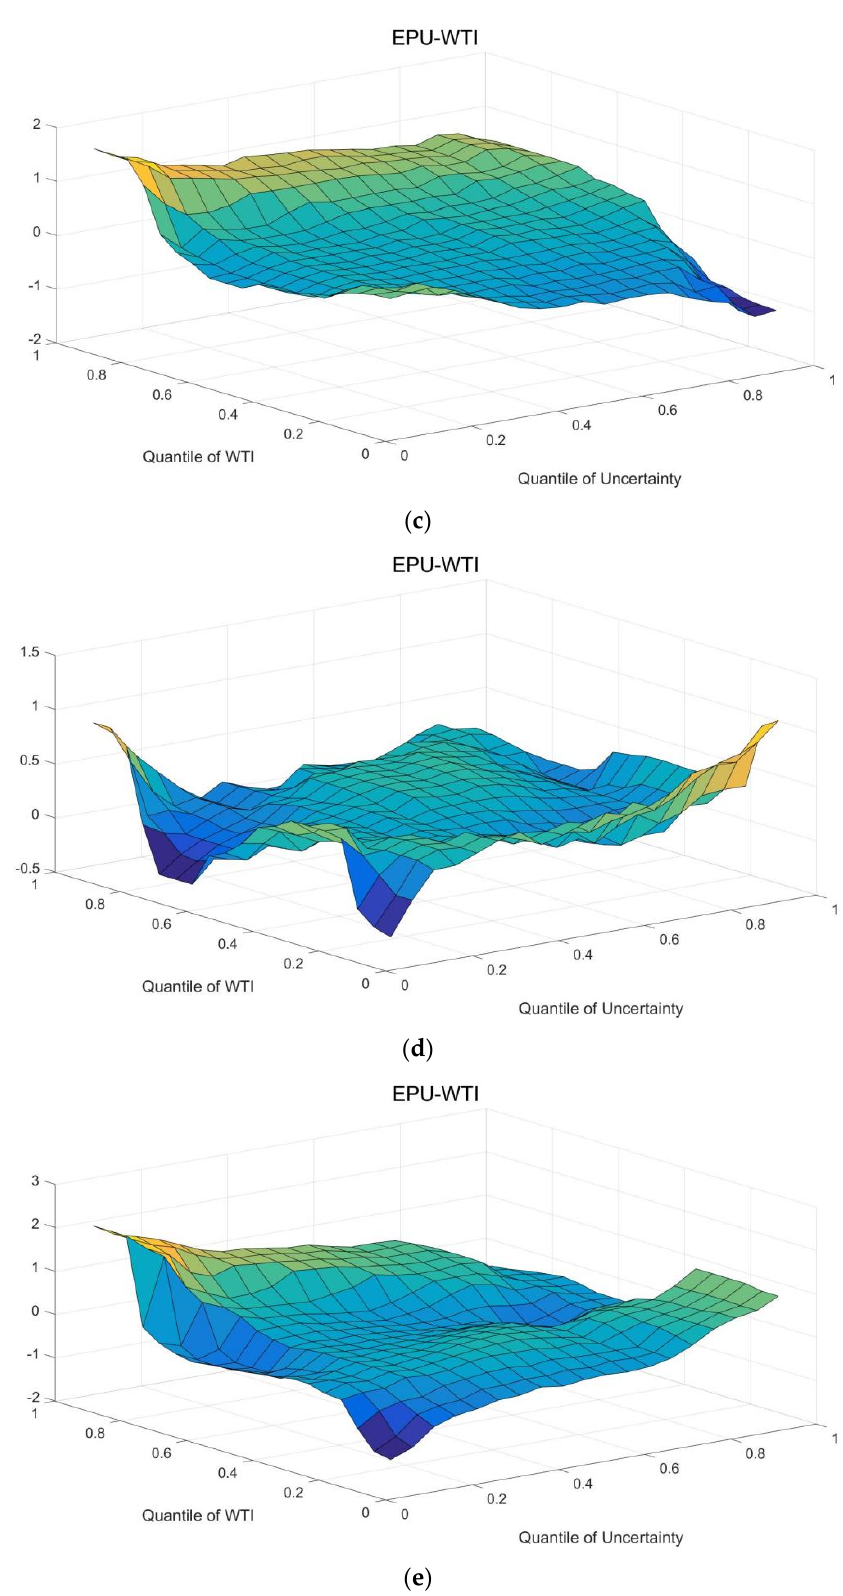
Figure 3. Estimation of the impact coefficients of the EPU on the WTI at different time scales. ( a ) The impact of the EPU on the WTI at D1; ( b ) The impact of the EPU on the WTI at D2; ( c ) The impact of the EPU on the WTI at D3; ( d ) The impact of the EPU on the WTI at D4; ( e ) The impact of the EPU on the WTI at D5.